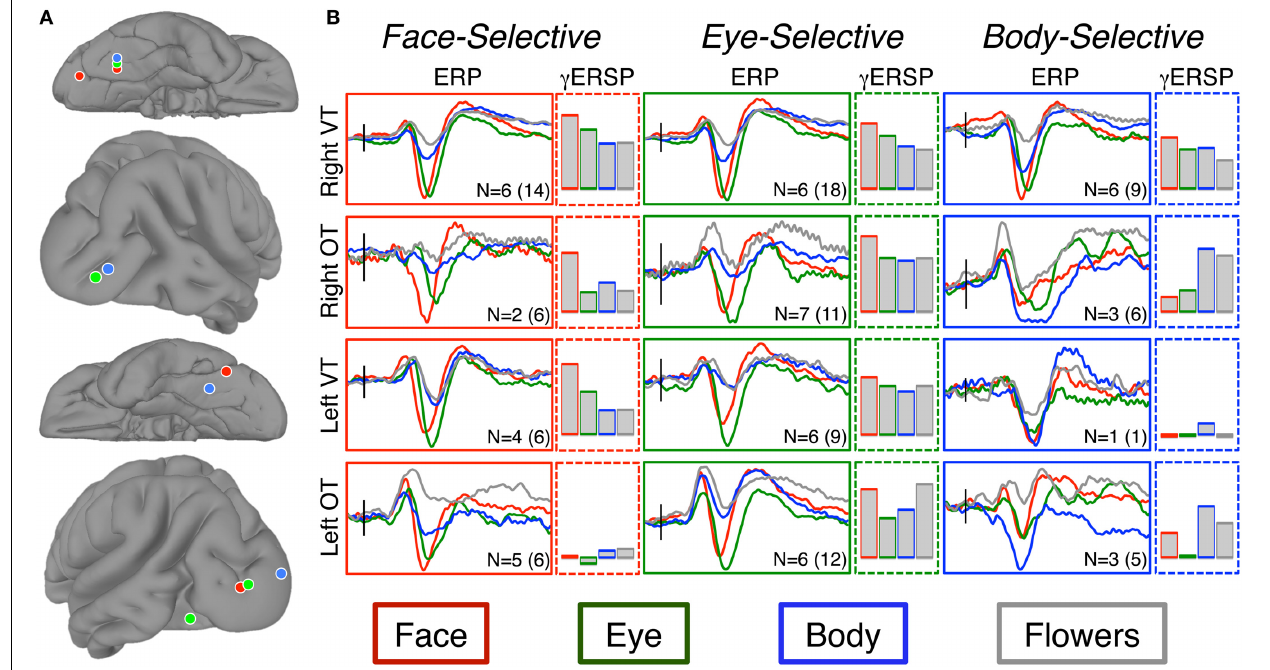
FIGURE 5 | Results of spatial-clustering. (A) The locations of the centroids from the k-means cluster analysis as seen on the right ventral tremporal (Right VT; 1st row), right occipitotemporal (Right OT; 2nd row), left ventral temporal (Left VT; 3rd row), and left occipitotemporal (Left OT; 4th row) surfaces. Centroids are displayed for faces (red), eyes (green), and bodies (blue). (B) Grand-average ERPs were calculated from the electrodes within each spatial cluster. The “I” bar in each plot represents 50 μ V along the y-axis and is